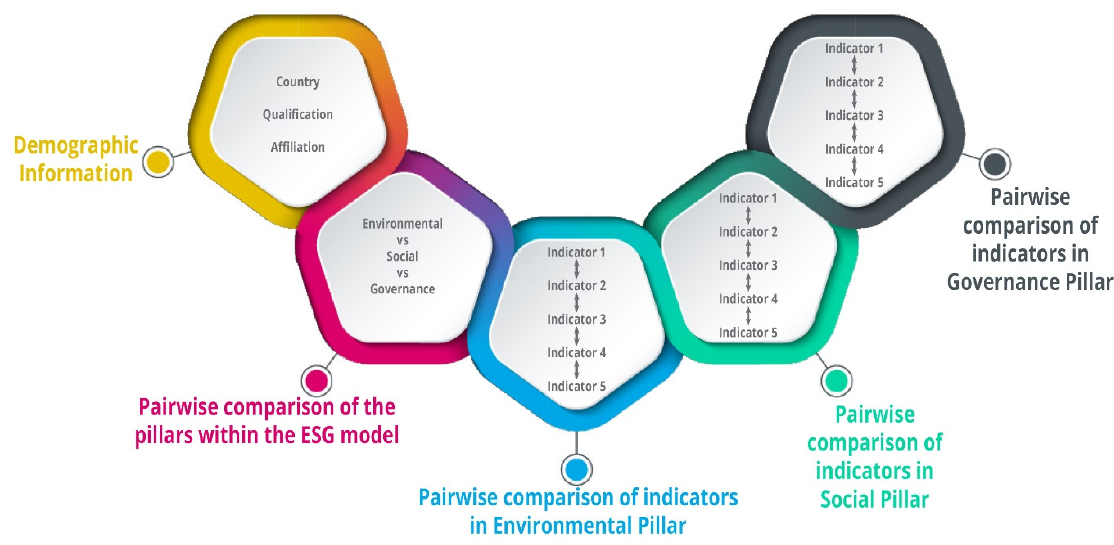
Figure 4. The research instrument used in the 4th survey. Source: Matemane (2022). Overall, 31 responses were obtained in the fourth round. This means overall, 53,43, 42 and 31 experts participated in the first, second, third round and fourth rounds, respectively.